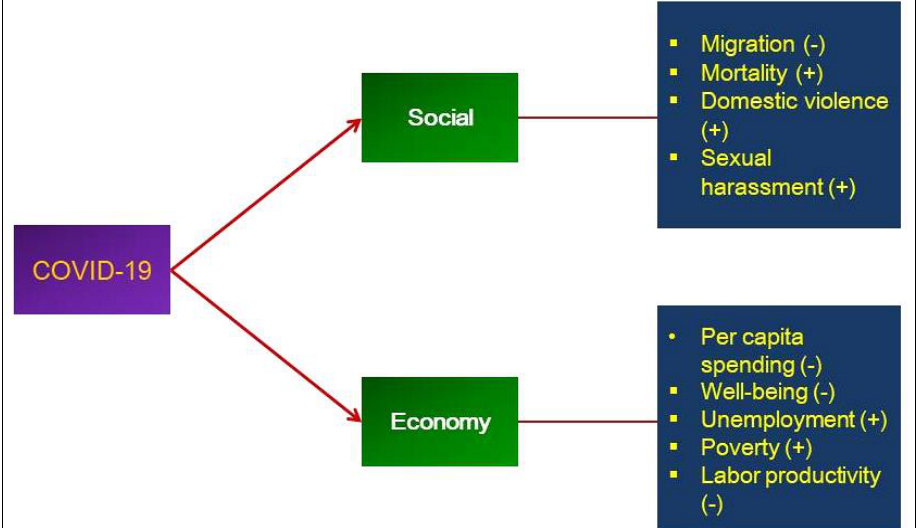
Figure 1. The theoretical framework (Adapted from